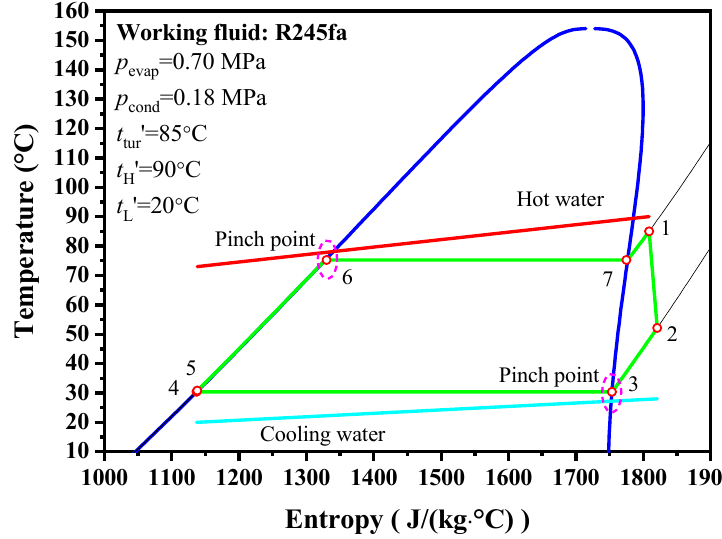
Figure 1. Scheme diagram of the organic Rankine cycle (ORC) (R245fa).